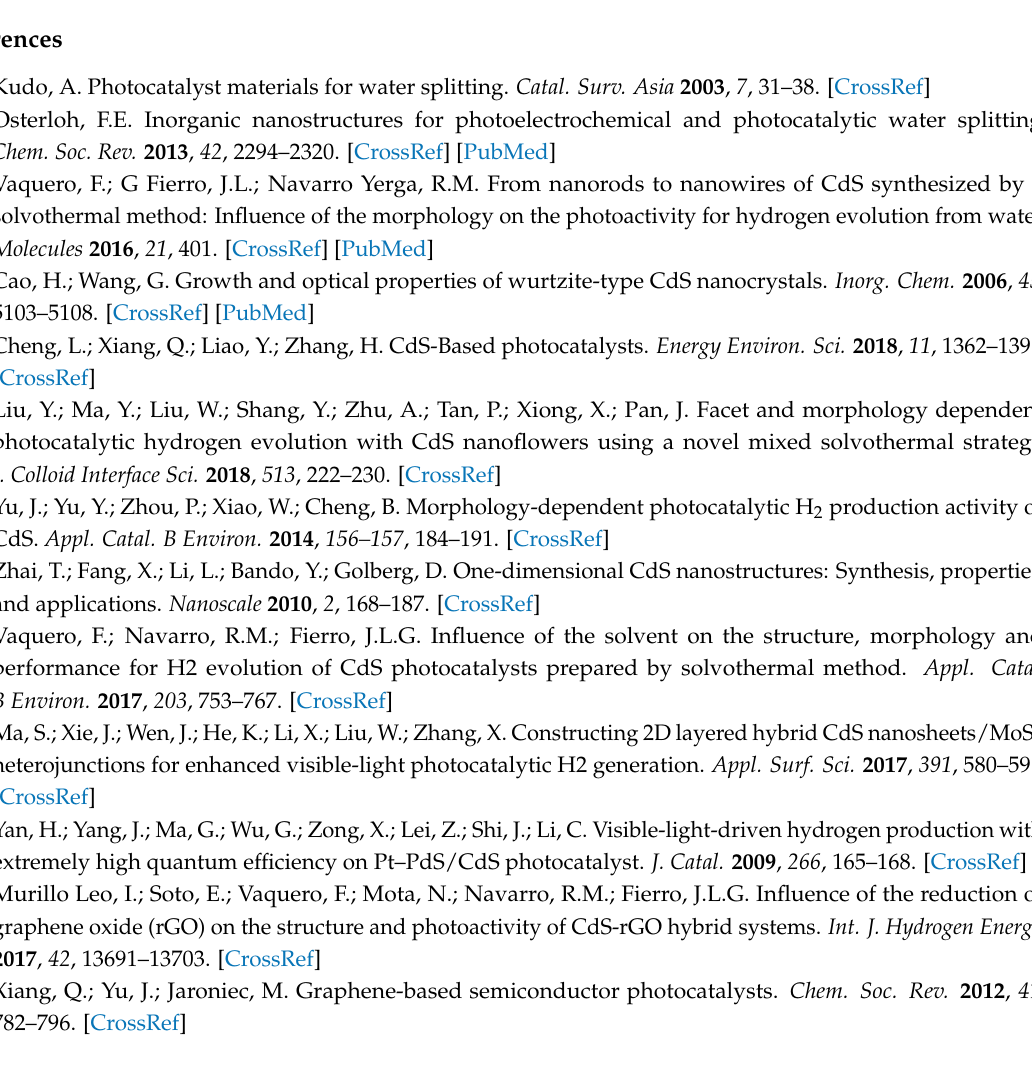
Supplementary Materials: The following are available online at http://www.mdpi.com/2073-4344/9/2/110/s1, Figure S1: William–Hall plot linear fit of AgCdS-T photocatalysts; Figure S2: Urbach tails linear fit of AgCdS-T photocatalysts: (a) AgCdS-90; (b) AgCdS-120; (c) AgCdS-150 and (d)